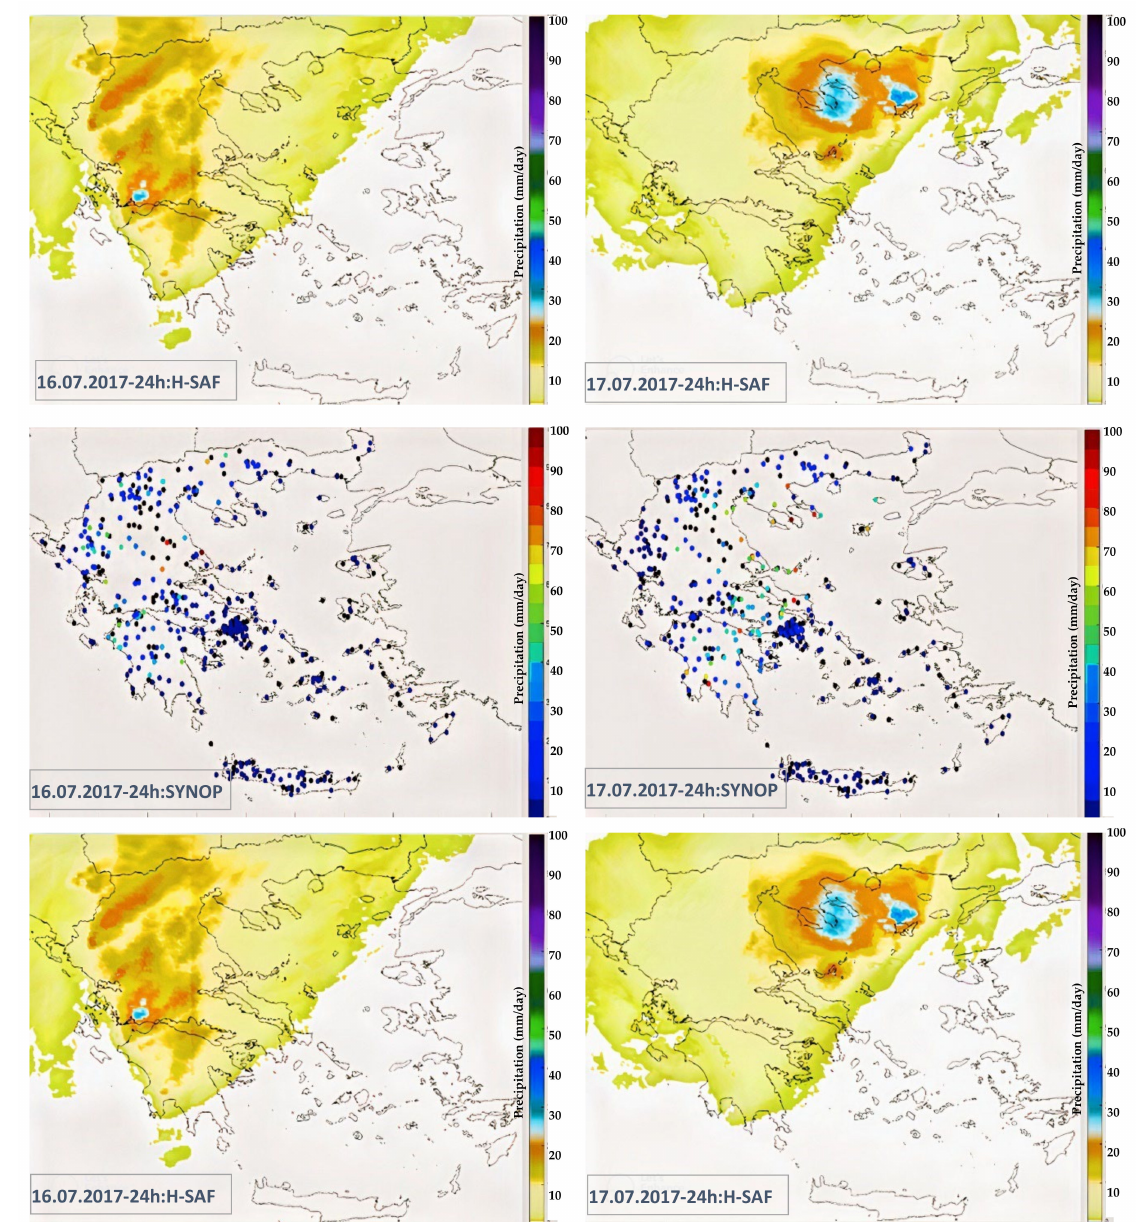
Figure 4. SYNOP (surface synoptic observations) of 24 h precipitation observations (first row, scale:10 mm/day—dark blue to 100 mm/day—dark red) and precipitation estimates from H-SAF (second row, <10 mm/day—light yellow to 100 mm/day—dark purple) for 16 July 2017 ( left ) and 17 July 2017 ( right